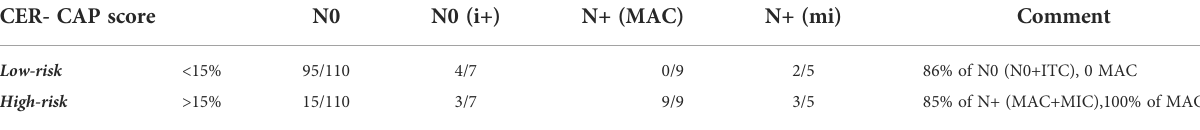
N0, node negative; N0(i+), isolated tumor cells; N+, node positive; MAC, macrometastasis; N+(mi),